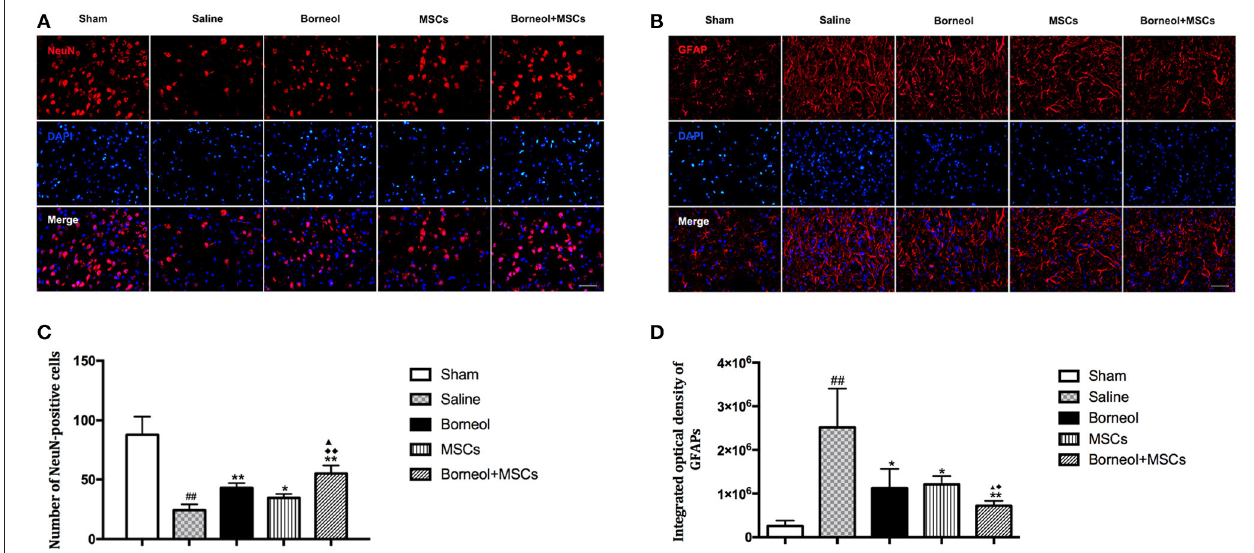
FIGURE 6 | Effect of borneol and MSCs transplantation on neurons and astrocytes at 14 d after MSCs transplantation. (A) Photomicrographs (*400) of NeuN positive cells in infarct zone. (B) Photomicrographs (*400) of GFAP positive cells in the lesion border. (C) Quantitative analysis of the number of NeuN positive cells. Data were expressed as mean ± SD . ## P < 0.01 compared with sham group; * P < 0.05, ** P < 0.01 compared with MCAO plus saline group; N P < 0.05 compared with borneol group; (cid:7)(cid:7) P < 0.01 compared with MSCs group. (D) Quantitative analysis of the number of GFAP positive cells. Data were expressed as mean ± SD . ## P < 0.01 compared with sham group; * P < 0.05, ** P < 0.01 compared with MCAO plus saline group; N P < 0.05 compared with borneol group; (cid:7) P < 0.05 compared with MSCs